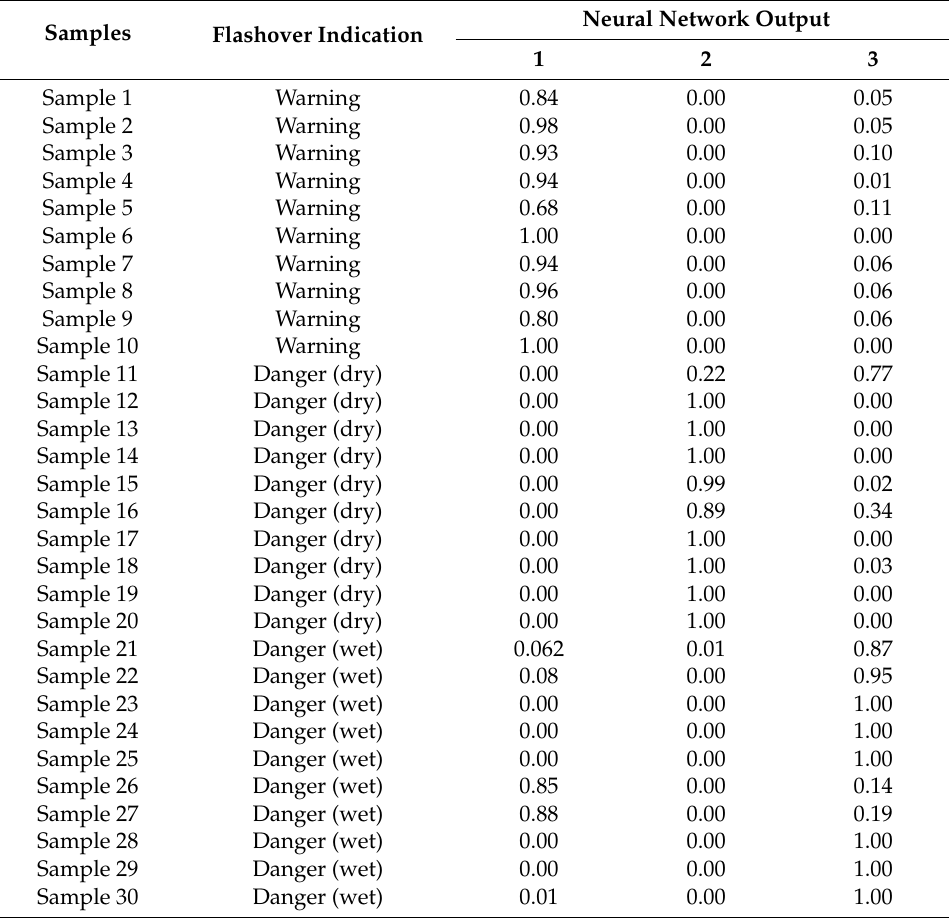
Table 17. Artificial neural network simulation